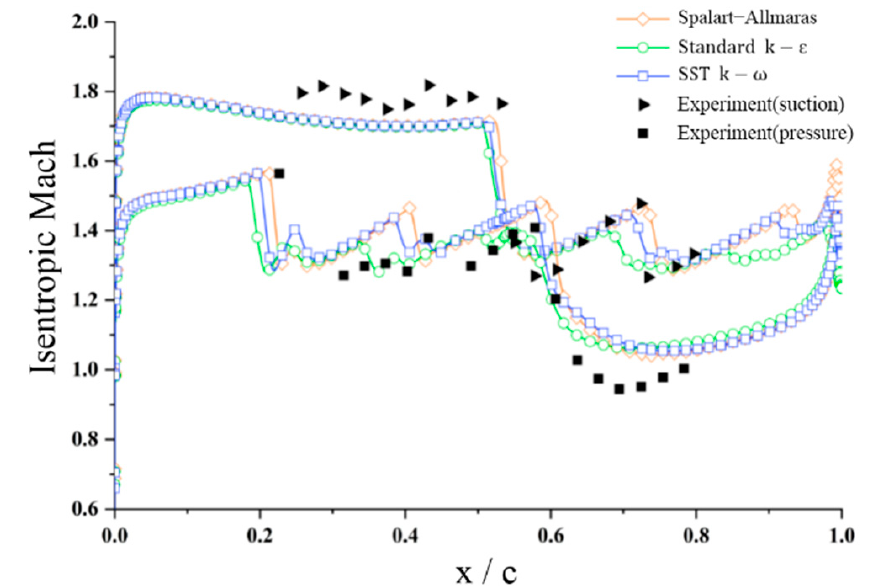
Figure 3. Isentropic Mach number distribution on blade surface [31].